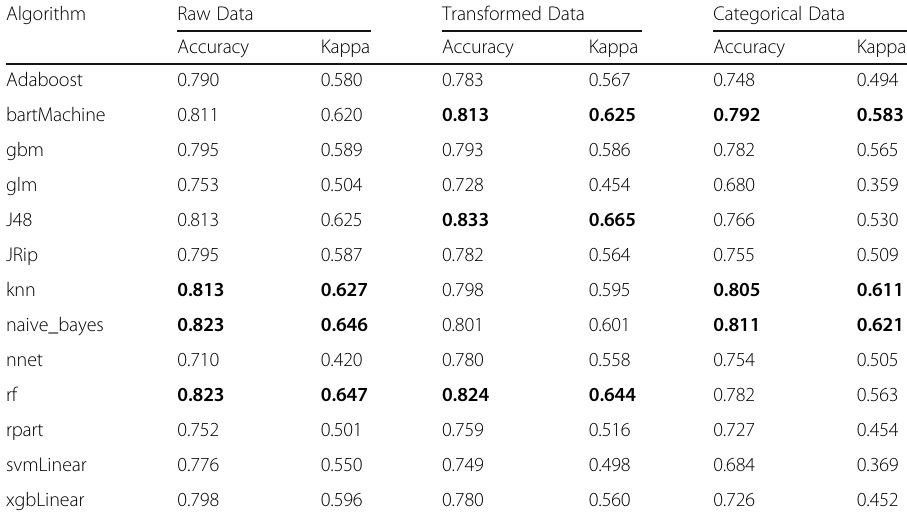
Table 4 Average scores of the models in terms of Accuracy and Kappa Algorithm Raw Data Transformed Data Categorical Data Accuracy Kappa